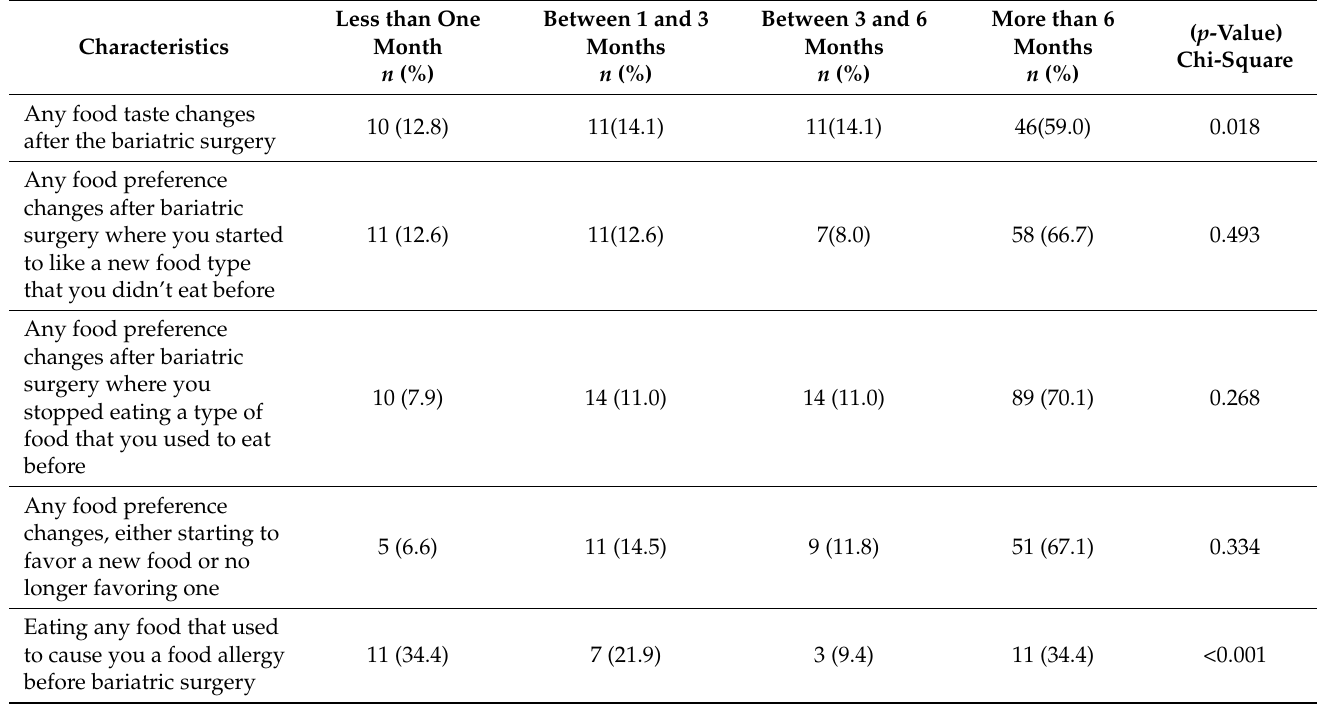
Table 3. Association between time since the surgery and changes in food preference and allergies.